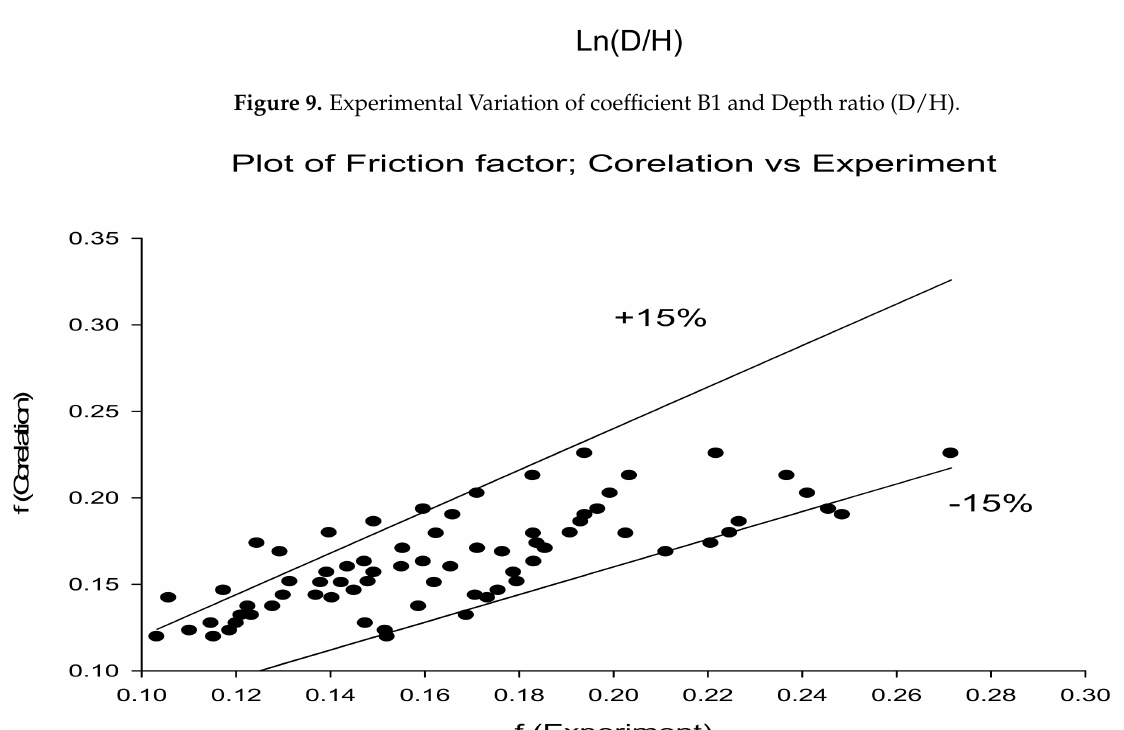
Figure 10. Experimental Variation of correlation and Friction